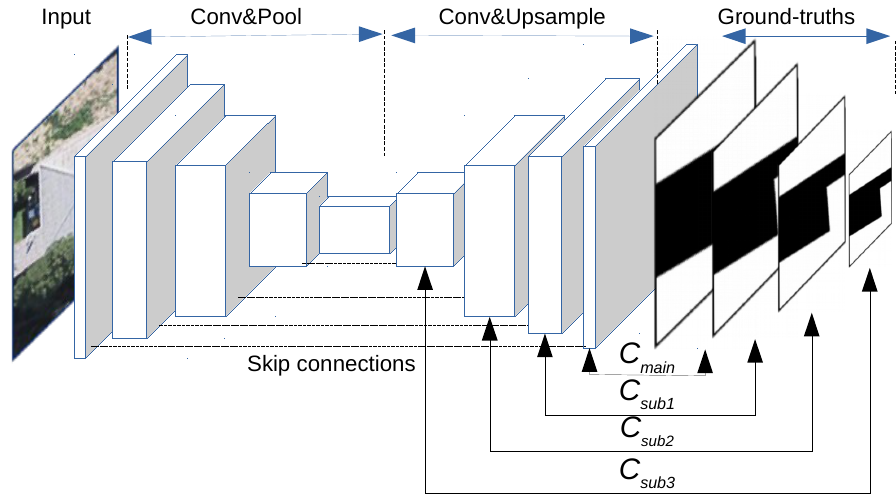
Figure 3. Network architecture of the proposed multi-constraint fully convolutional network (MC–FCN). The MC–FCN model adopts the basic structure of U–Net and adds three extra multi-scale constraints between upsampled layers and their corresponding ground